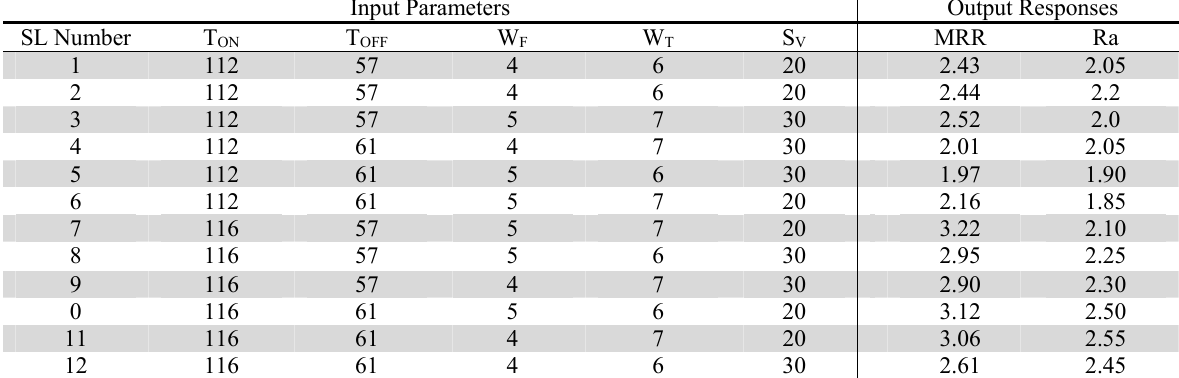
Taguchi L12 array and output results obtained for MRR and Surface roughness Input Parameters Output